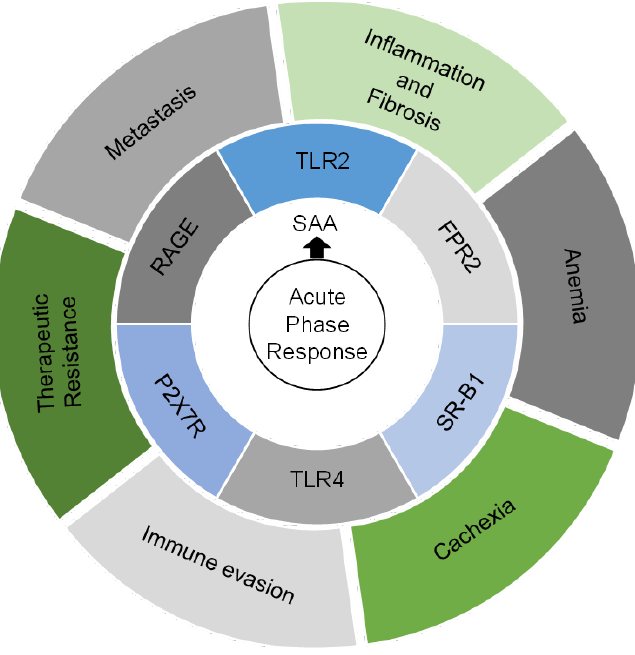
Figure 2. The acute phase response and its pathological impact in the setting cancer. This illustration encompasses six hallmarks associated with the acute phase response induced by cancer. Also shown are serum amyloid A (SAA) proteins which are released during the acute phase response and receptors that SAA proteins engage to support these hallmarks.